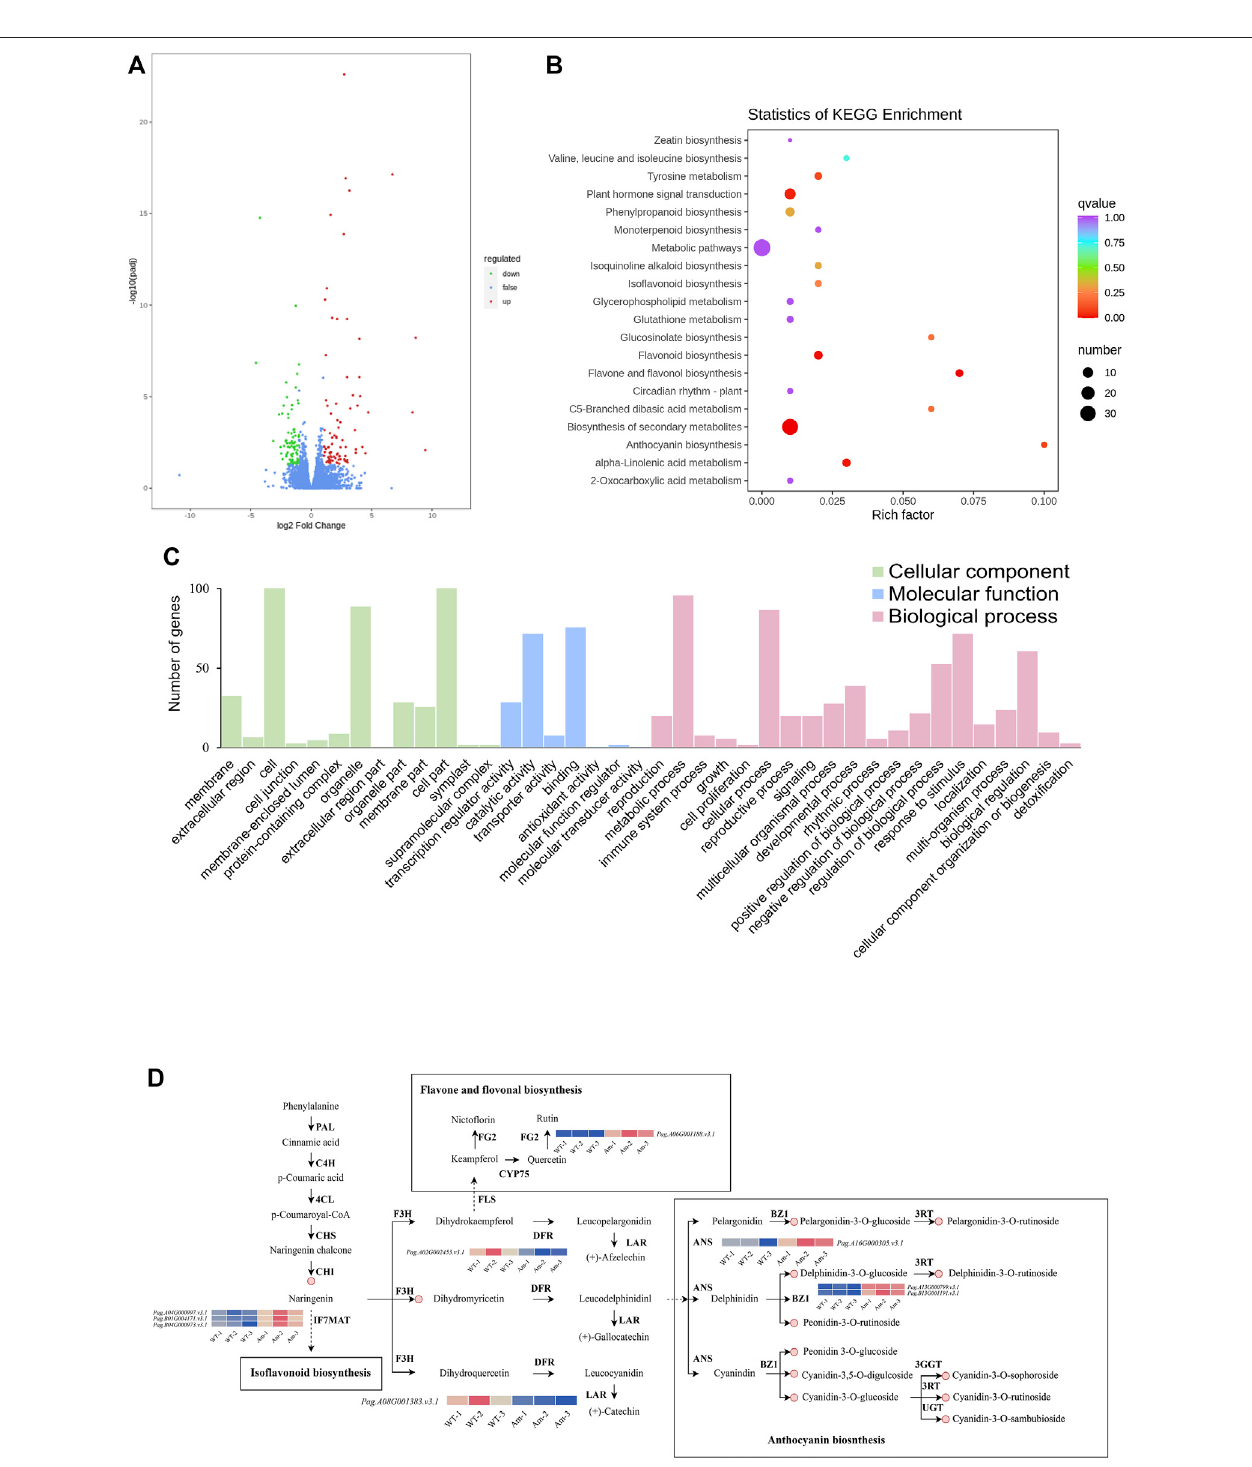
FIGURE 3 | Identi fi cation of the differentially expressed genes (DEGs) in WT vs. AM. (A) . Numbers of DEGs in volcano plots. (B) . KEGG enrichment analysis of the DEGs. (C) .Geneontology(GO)classi fi cationofDEGs. (D) .Differentialexpressionofgenesin fl avonoidandanthocyaninbiosynthesispathwaysinpoplar84Kleaf(WTvs. AM). PAL, phenylalanine ammonia-lyase; C4H, cinnamic acid 4-hydroxylase; 4CL, 4-coumarate CoA ligase; CHS, chalcone isomerase; CHI, chalcone isomerase; FG2, fl avonol-3-O-glucoside L -rhamnosyltransferase; CYP75, fl avonoid 3 ′ -monooxygenase; F3H, lavanone 3-hydroxylase; FLS, fl avonol synthase; IF7MAT, iso fl avone 7-O-glucoside-6 ″ -O-malonyltransferase; DFR, dihydro fl avonol 4-reductase; LAR, leucoanthocyanidin reductase; ANS, anthocyanidin synthase; BZ1, anthocyanidin 3- O-glucosyltransferase; 3RT, pelargonidin 3-O-rutinoside + UDP; 3GGT, anthocyanidin 3-O-glucoside 2 ″ -O-glucosyltransferase; UGT, anthocyanidin 3-O-glucoside 5-